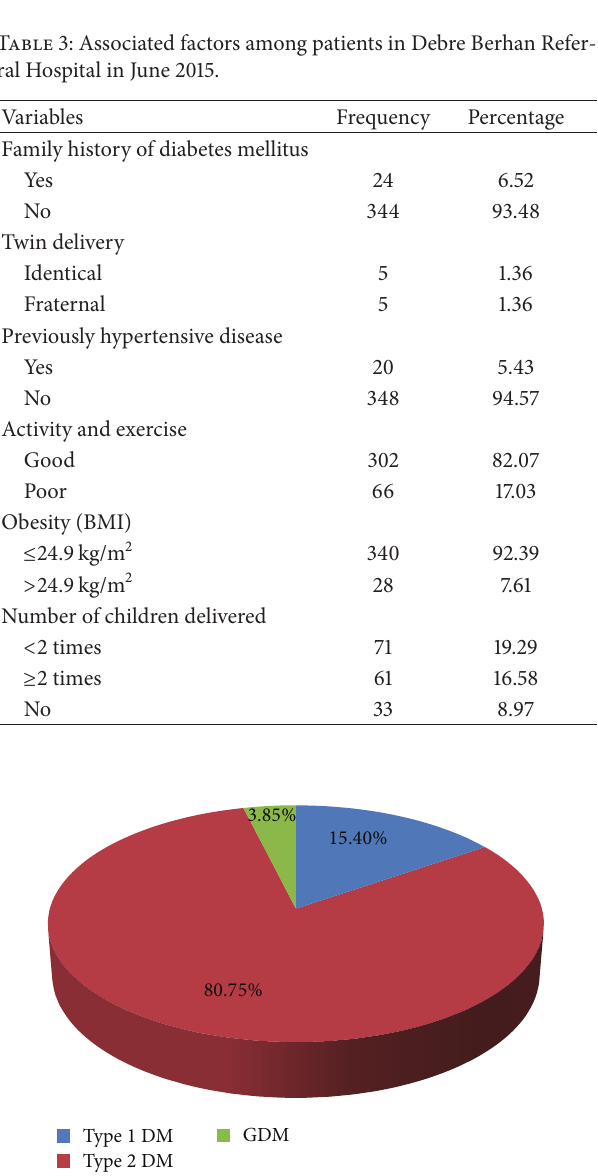
Figure 1: Diabetes mellitus category of patients in Debre Berhan Referral Hospital in June 2015.